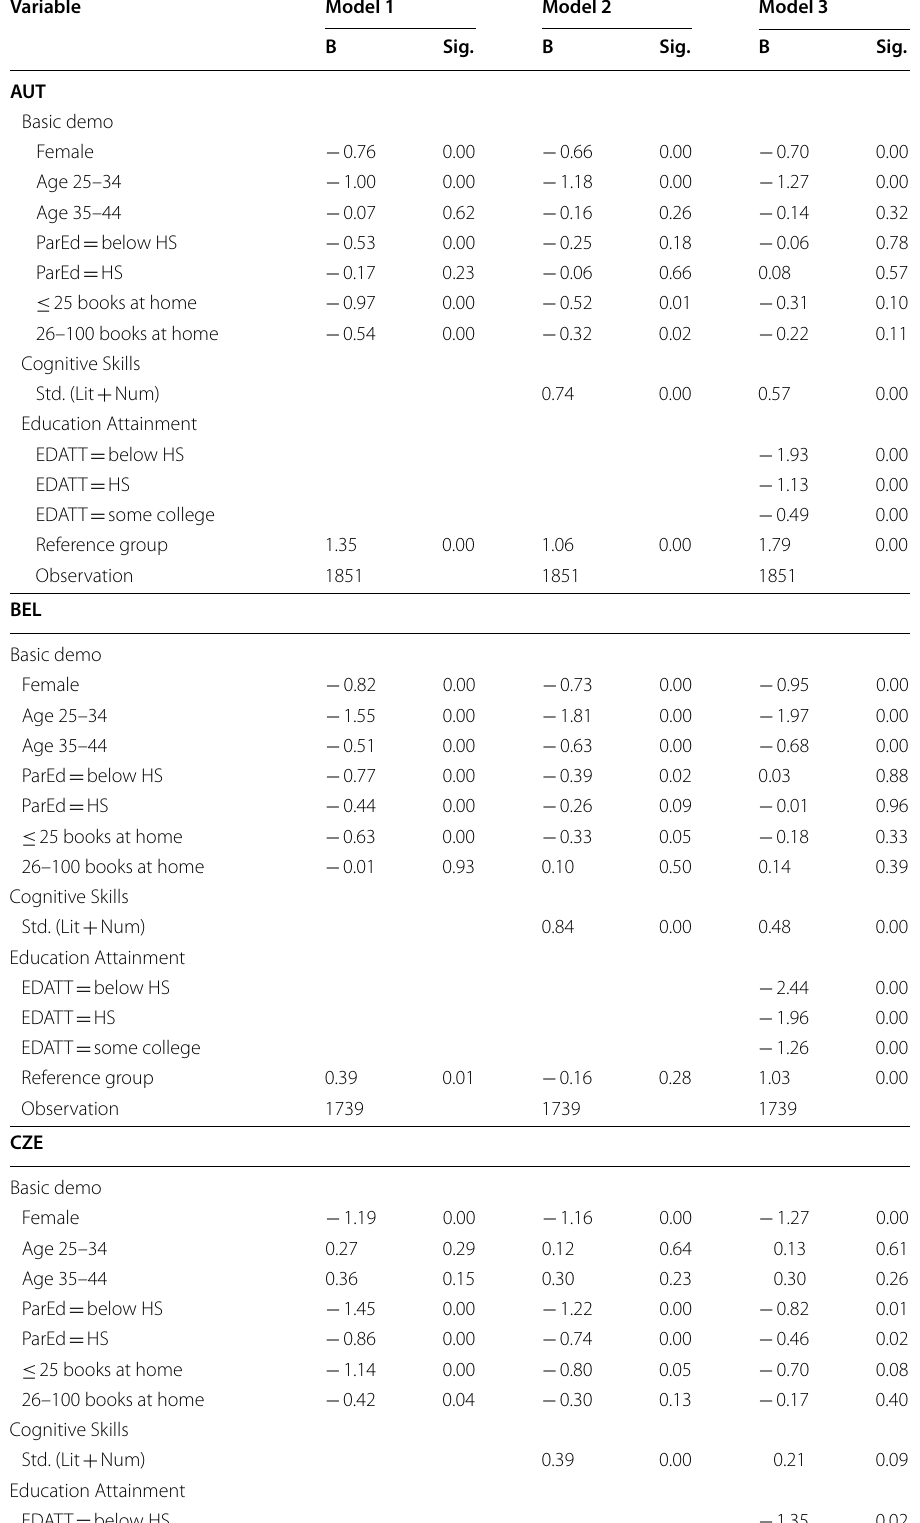
Table 7 Logistic regressions for Q4